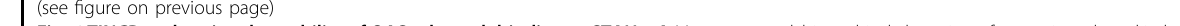
Fig. 6 TINCR undermine the stability of OAS1 through binding to STAU1. A Mean centered, hierarchical clustering of transcripts altered in breast cancer cells treated with scrambled siRNA or si-TINCR 2#, with three repeats. B , C qRT-PCR analysis was used to validate the changes of several top regulated mRNAs upon TINCR depletion and overexpression in T47D and MCF-7 cells. D OAS1 mRNA expression upon STAU1 depletion, as detected by quantitative reverse transcription (qRT – PCR). E OAS1 mRNA expression was detected by qRT – PCR in pcDNA-TINCR and si-STAU1 co-transfected T47D and MCF-7 cells. F Protein level of OAS1 was detected by western blot assays in pcDNA-TINCR and si-STAU1 co-transfected T47D and MCF-7 cells. G Bioinformatics tool (http://bioinfo.bjmu.edu.cn/lncpro/) was used to evaluate the combination possibility between several top upregulated mRNAs and STAU1. Predictions with probabilities >0.5 were considered “ positive ” , indicating that the corresponding RNA and protein are likely to interact. OAS1 showed high possibility to interact with STAU1. H RIP assay was performed with IgG or STAU1 antibodies in T47D cells, and the coprecipitated RNA was subjected to qRT-PCR for OAS1. I The predicted TINCR binding site in OAS1 (OAS1-3 ′ UTR-Wt) and the designed mutant sequence (YY2-30 UTR-Mut) are shown (up). Luciferase reporter gene assays of T47D and MCF-7 cells are shown (down) (OAS1-3 ′ UTR-Wt + TINCR-NC group is seen as control). J , K TINCR and STAU1 control OAS1 mRNA stability. RNA stability assays were performed in T47D cells using Actinomycin D to disrupt RNA synthesis, and the degradation rates of the OAS1 mRNA were measured over 9 h. Values are shown as the mean ± s.d in